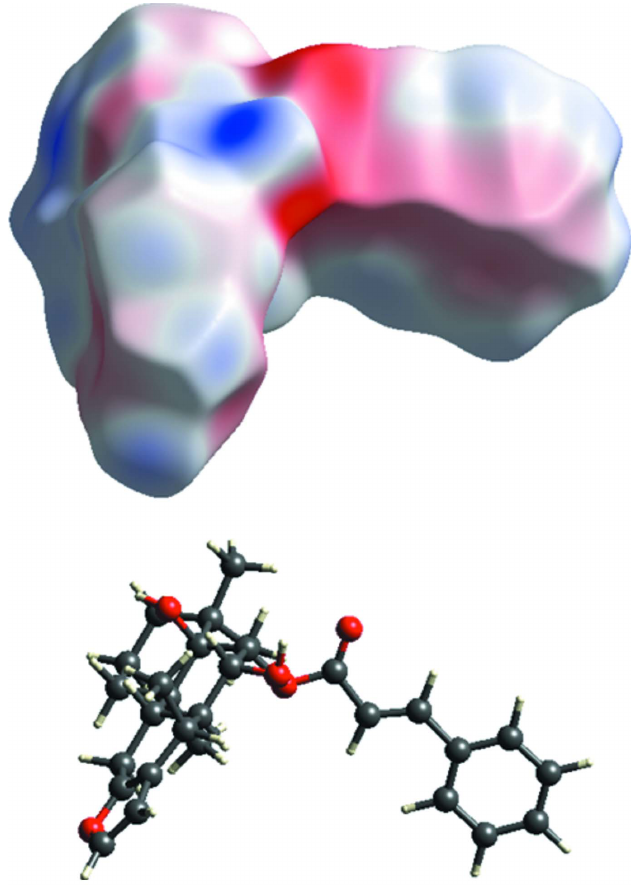
Figure 4 Electrostatic potential surface generated incorporated with Hirshfeld surface for compound (I).